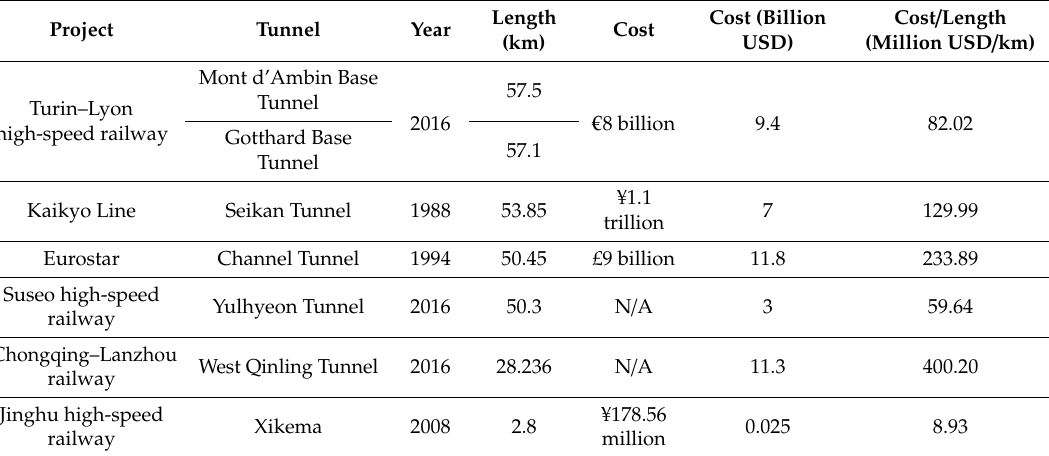
Table 3. Examples of construction cost of railway